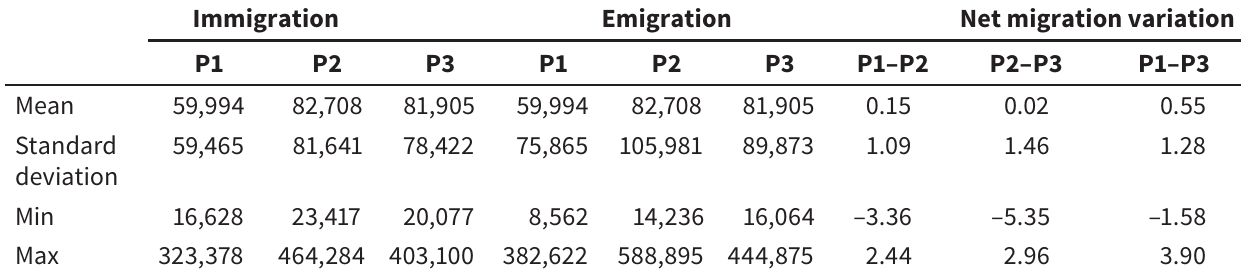
Descriptive statistics on migration